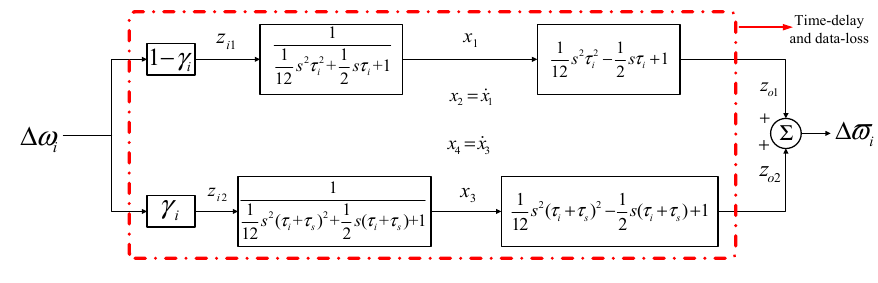
Figure 2. Linearized model of the feedback signal.